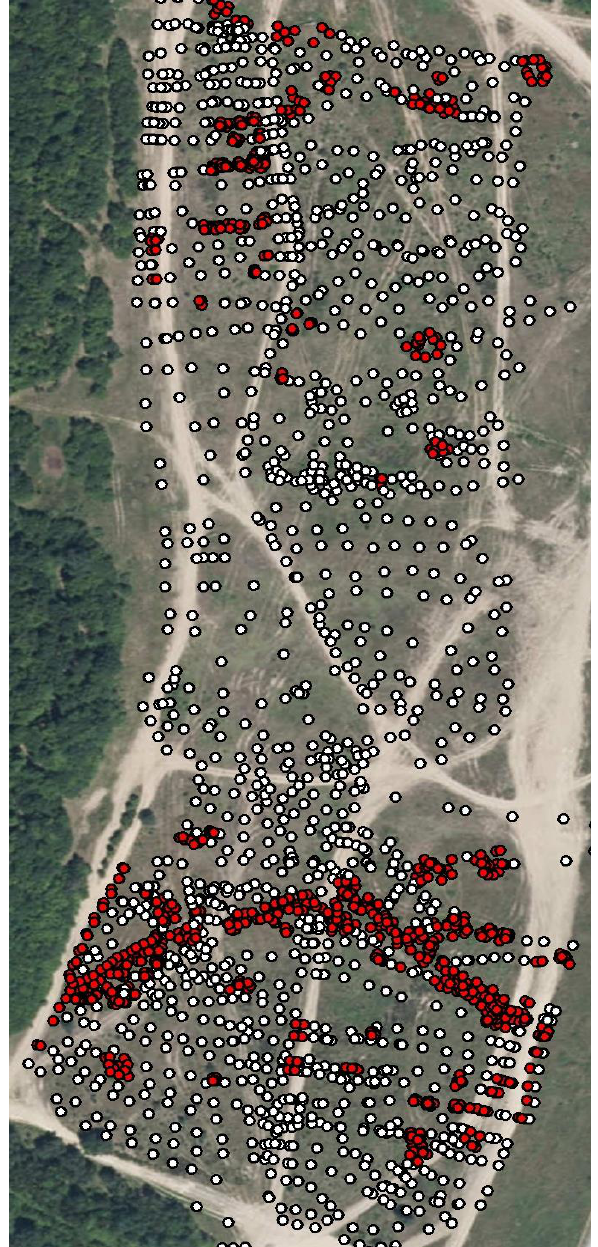
Figure 3. Distribution of control points in the Dědice area (red dots represent micro-relief objects)